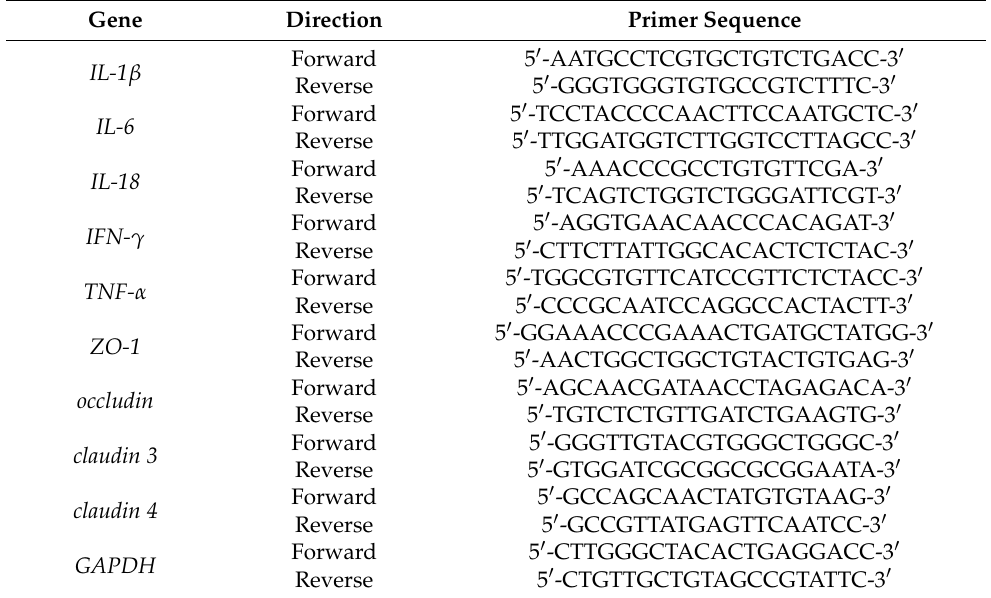
Table 1. Rat primers for real-time reverse transcription-polymerase chain reaction (RT-PCR)